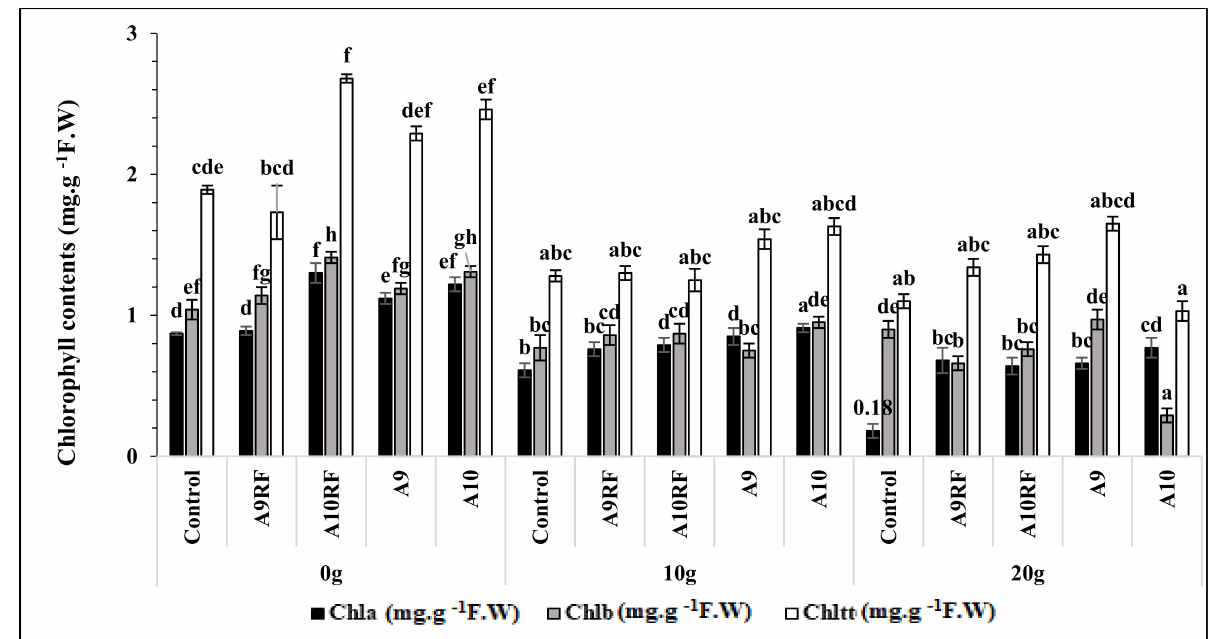
Figure 3. Effects of different fungal complexes and monospecific isolates on the chlorophyll contents of ten-month aged date palm seedlings under different salt stress levels. Graphs indexed by the same letter did not significantly differ according to Tukey (HSD) test ( p <